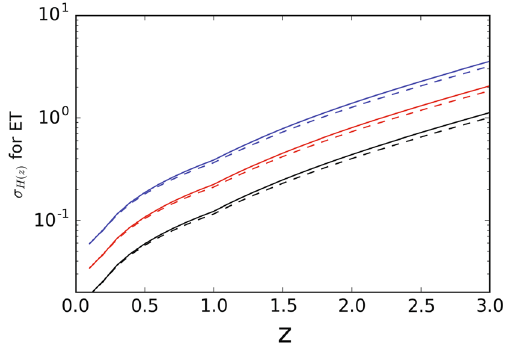
Fig. 6 Same as Fig. 5, but for ET